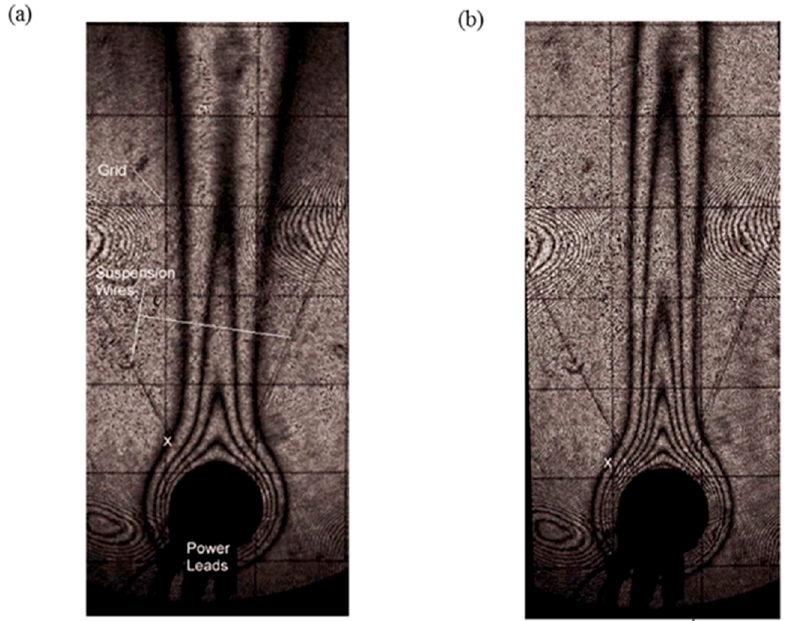
Figure 21. DMS interferograms obtained by Newport et al. [116] in a free convective air flow around a heated cylinder, for ( a ) Ra = 6.8 × 10 3 , and ( b ) for Ra = 1.4 × 10 4 . Reprinted by permission from Ref. [116], Journal of Electronic Packaging, Copyright © 2022 ASME.